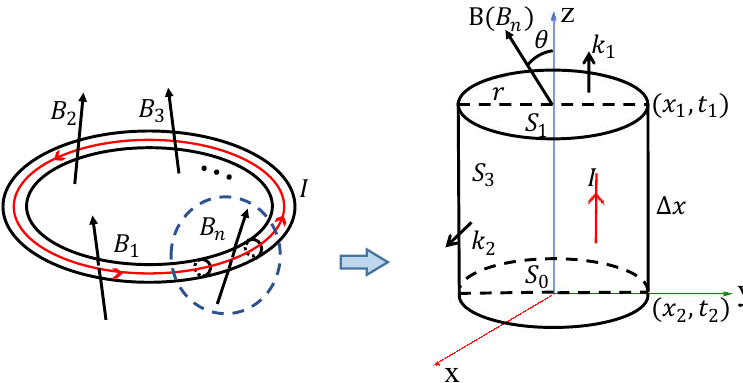
Figure 6. Simplified diagram of induced current in single turn coil. 𝐵 1 to 𝐵 𝑛 represents magnetic induction lines in different directions across the coil. 𝜃 stands for one of the angles between cur- rent flow and magnetic induction lines.